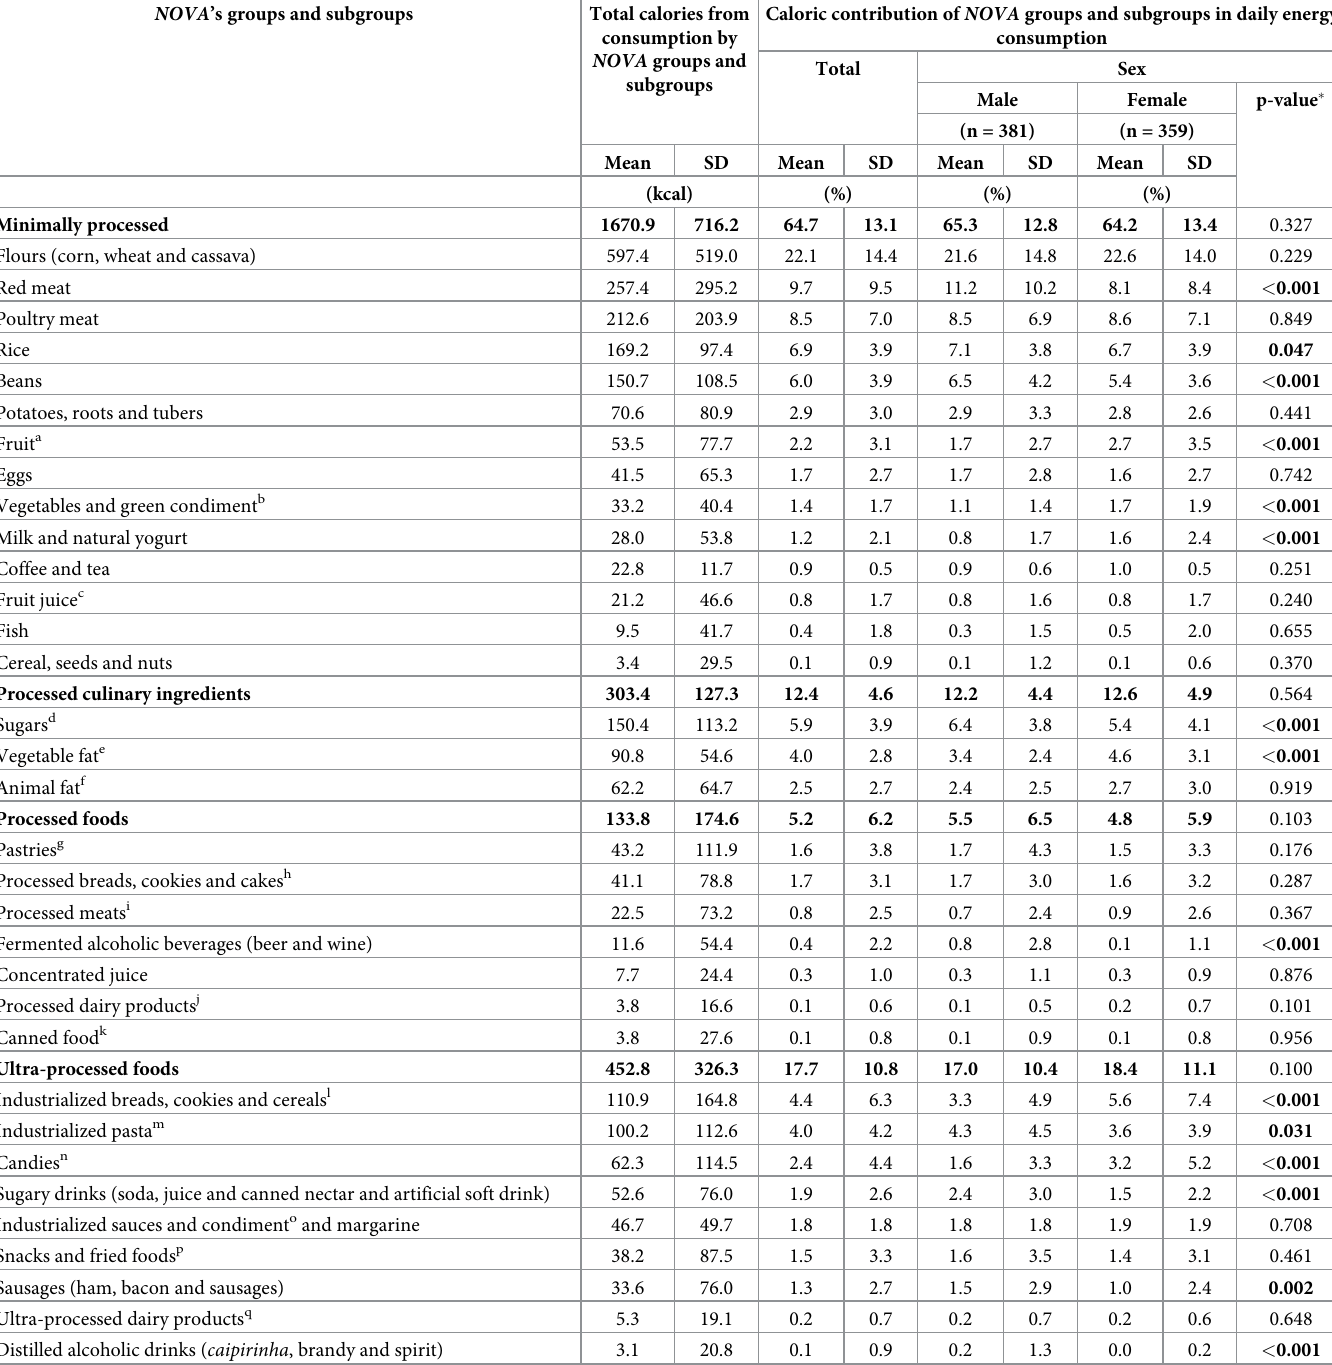
Table 2. Total calories and caloric contribution of NOVA groups and subgroups to the food consumption of Brazilian farmers. NOVA ’s groups and